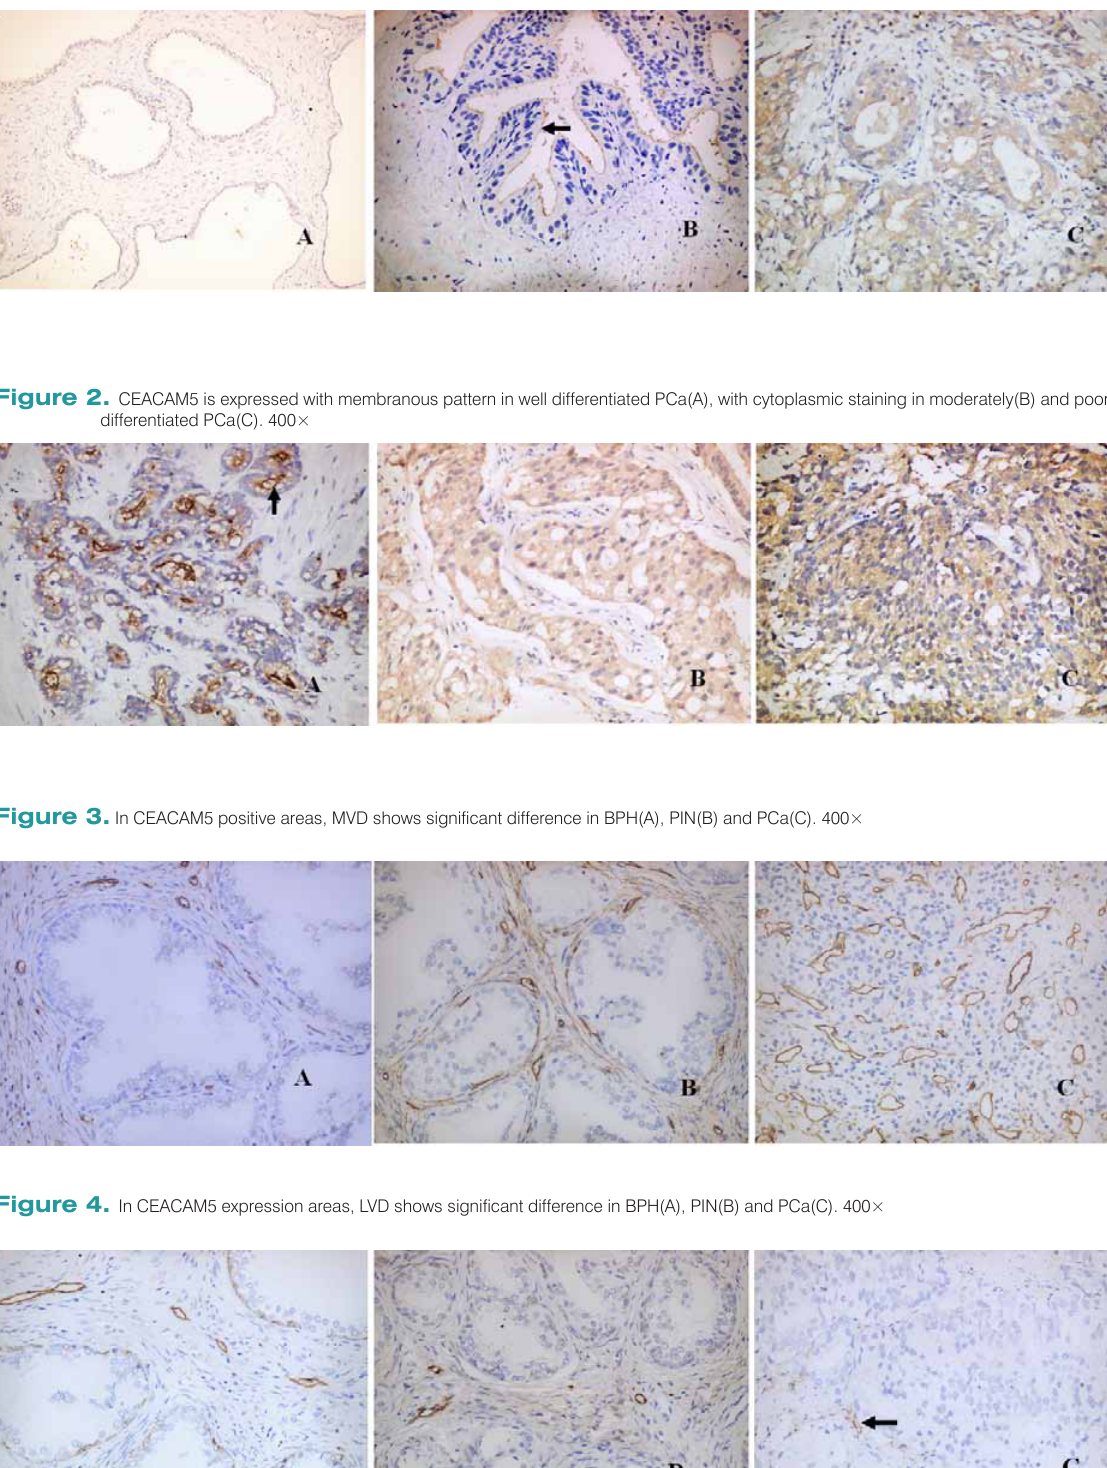
Figure 1. CEACAM5 is not expressed in BPH(A), expressed with membranous pattern in PIN, and overexpressed in PCa(C). A 100×, B and C 400×